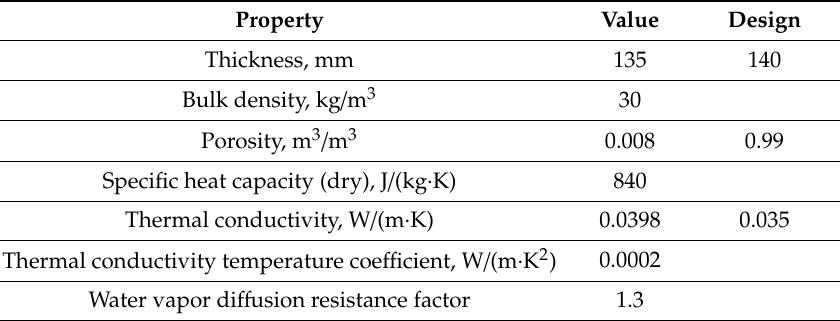
Table A20. Fiberglass insulation property